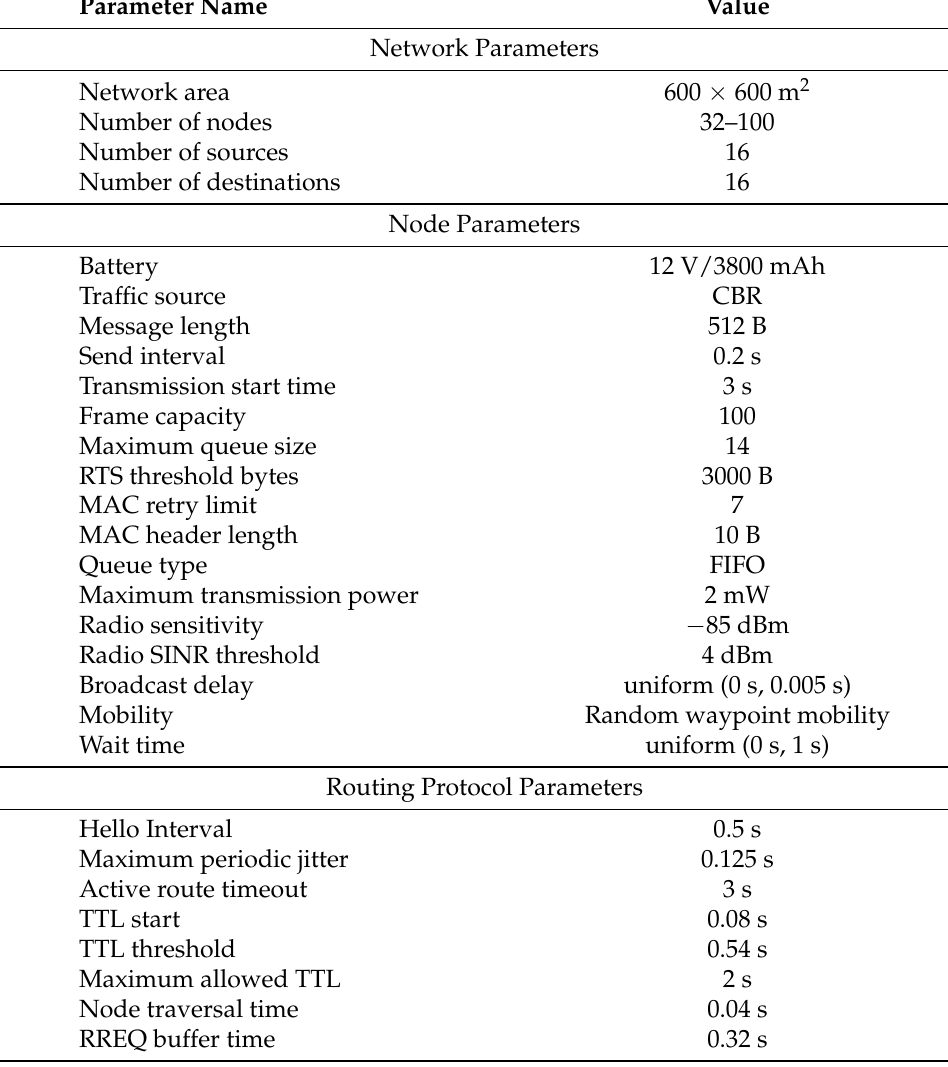
Table 4. Simulation